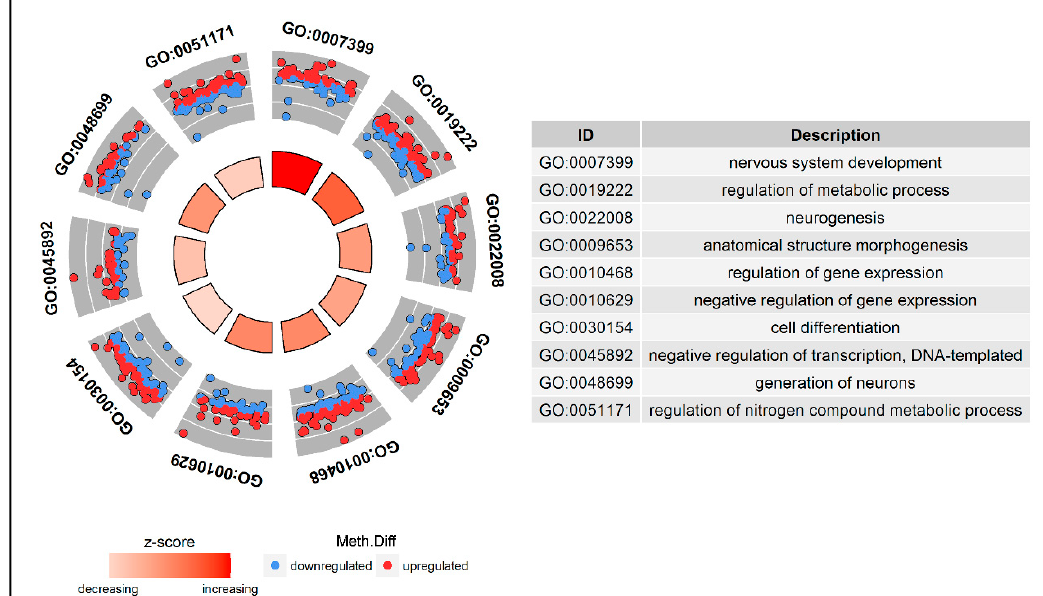
Figure 5. Gene Ontology (GO) circle plot for differentially methylated genes (DMGs). The inner ring is a bar plot where the height of the bar indicates the significance of the term ( q value), and color corresponds to the z-score. The outer wheel shows a scatter plot of methylation difference for each gene under the Gene Ontology(GO) terms. Red dots indicate hyper-methylated genes and blue dots show hypo-methylated genes.